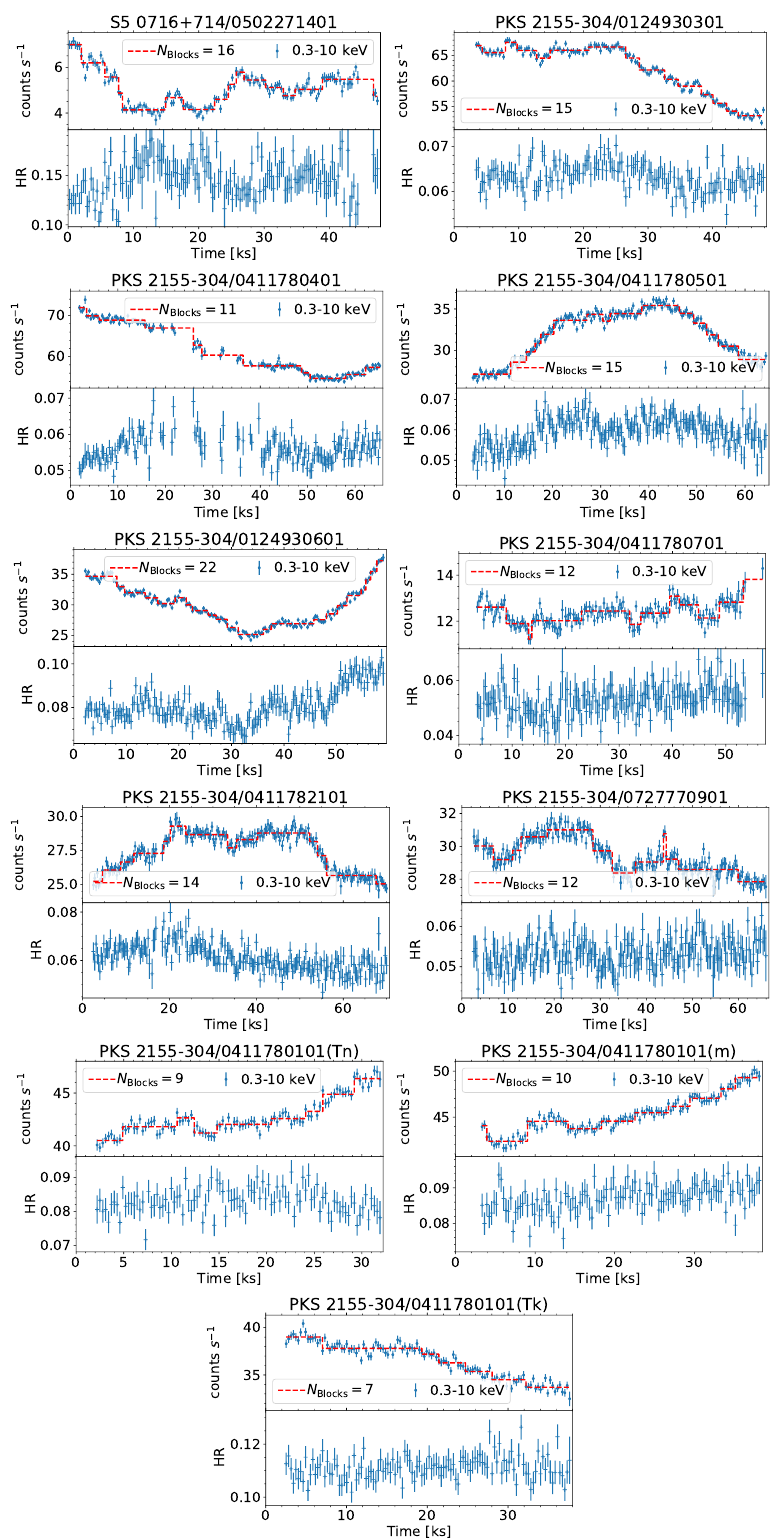
Figure 1. XMM-Newton X-ray light curves of blazars S5 0716+714 (IBL) and PKS 2155-304 (HBL) using 300 s binning along with the hardness ratio. The dashed line shows the Bayesian blocks, marking changes in count rate with time. “Tn”, “m”, and “Tk” within the parenthesis in the last three light curves refer to the filters “thin”, “medium”, and “thick” respectively (see Table